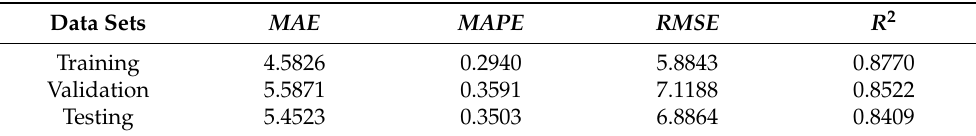
Table 7. Prediction performance of polynomial calculation